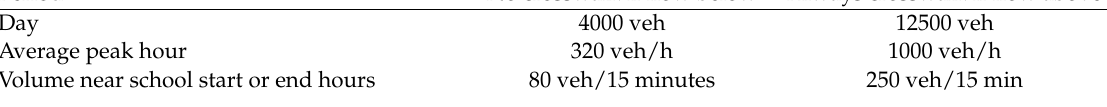
This situation with crosswalks is hence considered in this